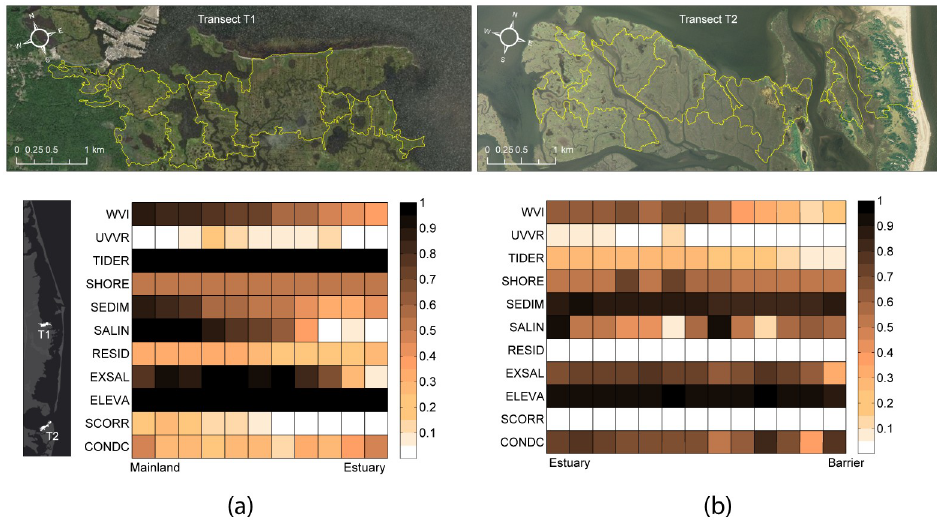
Fig 8. Change in underlying parameters. a) along a west-east transect T1 over the Manahawkin marsh; and b) along a transect T2 from the barrier to the estuary in Great Bay. The values are in terms of WVI in the entire estuary. The transect locations are indicated in the adjacent